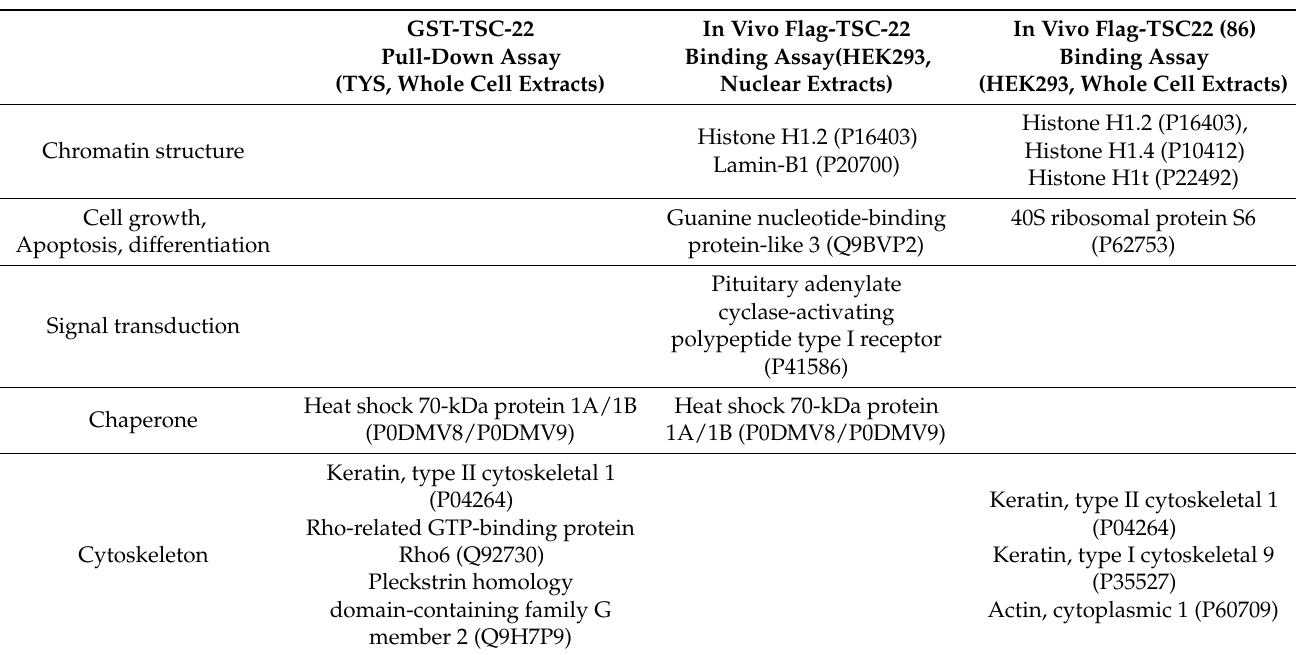
Figure 2. Identification of TSC-22 (TSC22D1-2)-binding proteins by in vitro GST pull down. ← : TSC-22-binding protein. a: Elongation factor 1-gamma, b: Keratin, type II cytoskeletal 1, c: Carbonyl reductase [NADPH] 1, d: Pleckstrin homology domain-containing family G member 2, e: Rho-related GTP-binding protein Rho6, f: Heat shock 70-kDa protein 1A/1B. Table 2. Candidates of TSC-22 binding proteins identified by MS (UniProt Accession number).